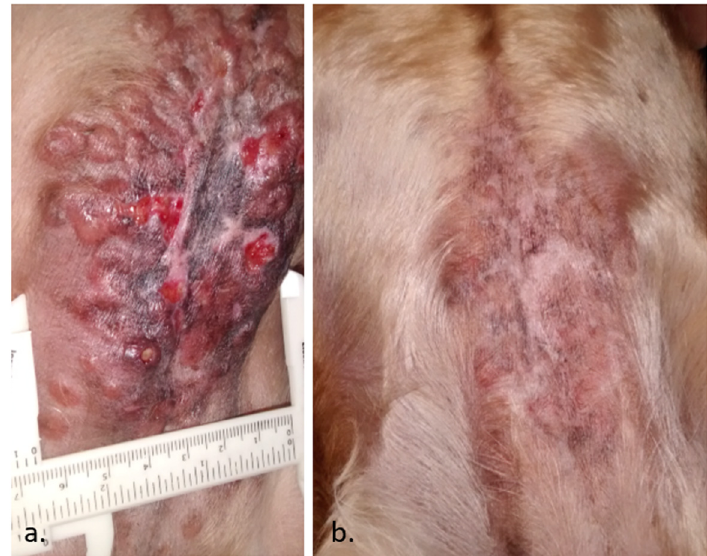
Figure 1. A case of a canine sebaceous gland carcinoma in a 4-year-old female cocker spaniel. In ( a ), the initial presentation, with a large lesion of 15 × 6.5 cm containing multiple nodules and ulcers. Only 20% of the tumors were treated with Electrochemotherapy (ECT) due to the large extension and spread of the disease, intending to repeat more sessions in the future. In ( b ), the patient achieved a complete response within 12 weeks of a single ECT session. Fifteen months later, the patient remains free of disease (data not published).